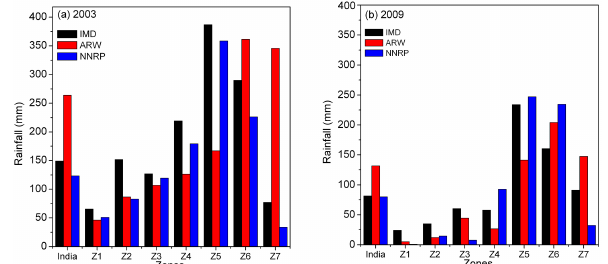
Figure 10. Variation of 5-day mean wind speed (ms − 1 ) during the years (a) 2003 and (b) 2009 from simulation and NCEP FNL anal- ysis calculated over the region 2–16 ◦ N, 52–64 ◦